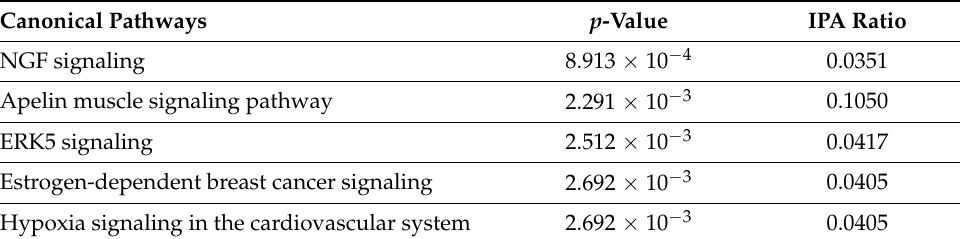
Table 6. Top 5 canonical pathways affected by TAC/PL treatment compared to TAC alone, as highlighted by